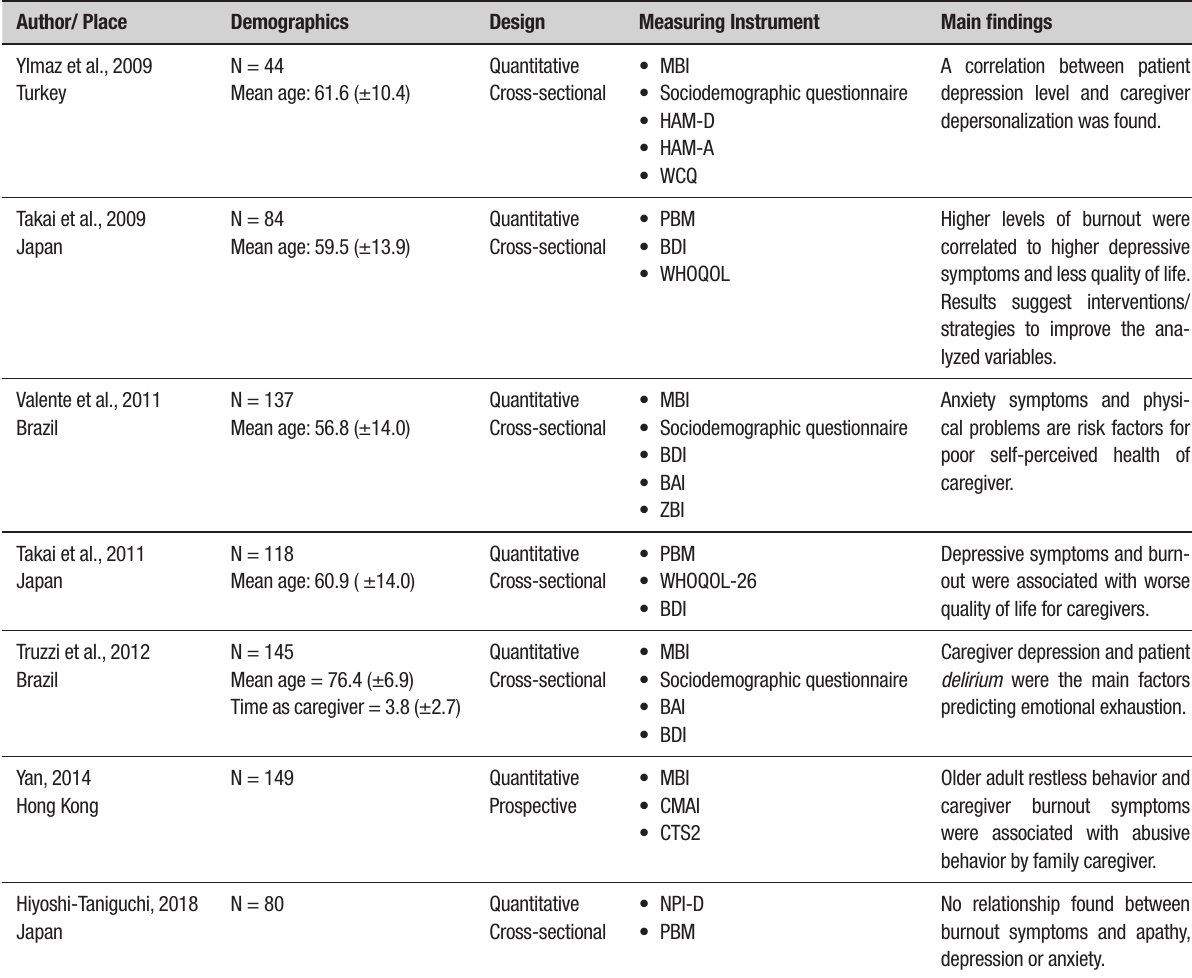
Table 1. Burnout syndrome studies in caregivers of older adults with